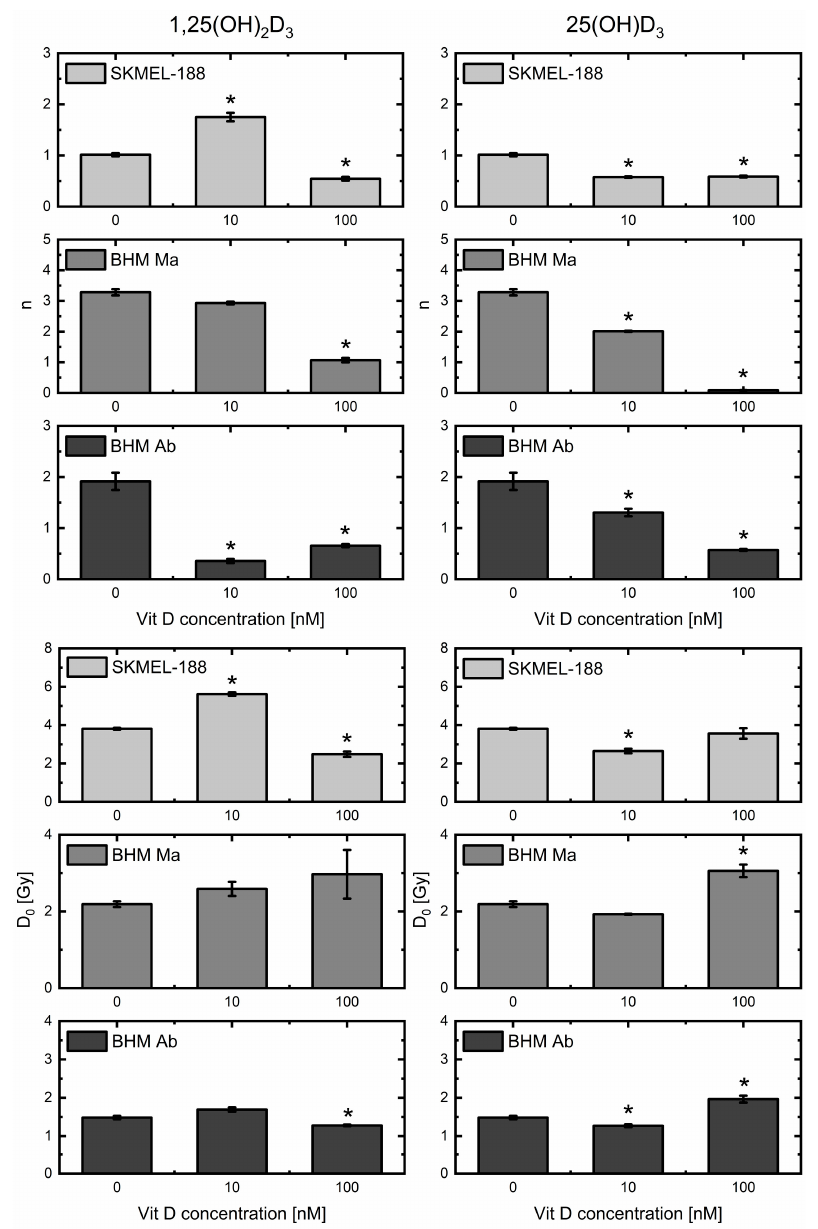
Figure 5. Coefficients n ( upper panel) and D 0 ( lower panel) from multi-target single hit model calculated for cells pre-treated with calcitriol (1,25(OH) 2 D 3 ) and calcidiol (25(OH)D 3 ) and irradiated with proton beam. Surviving fraction was determined from the model described by Buch et al. [34], based on the experimental data from SKMel-188, BHM Ma and BHM Ab cell number, counted every 24 h for 4 days in culture after irradiation. * denotes statistical significance p < 0.05 against control (0 nM of vitamin D 3 derivative).